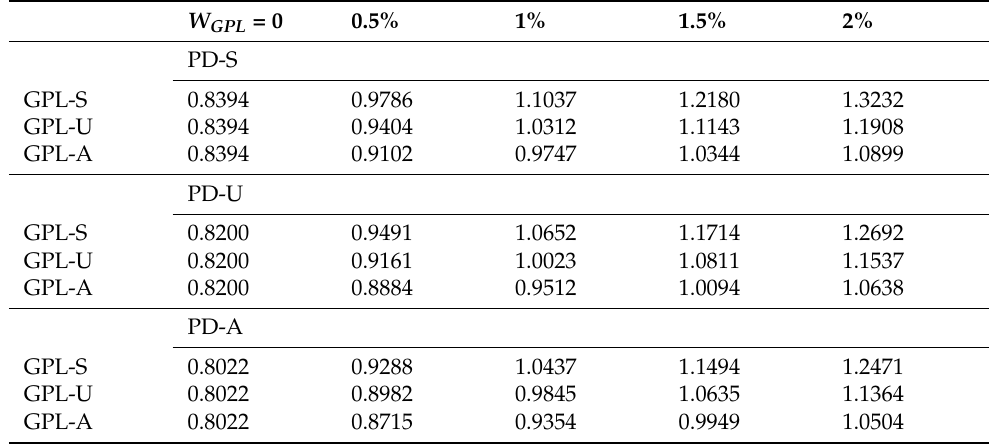
Table 3. Critical pressure of ring-stiffened porous GPLRC cylindrical shells for different weight fractions and GPL distributions.